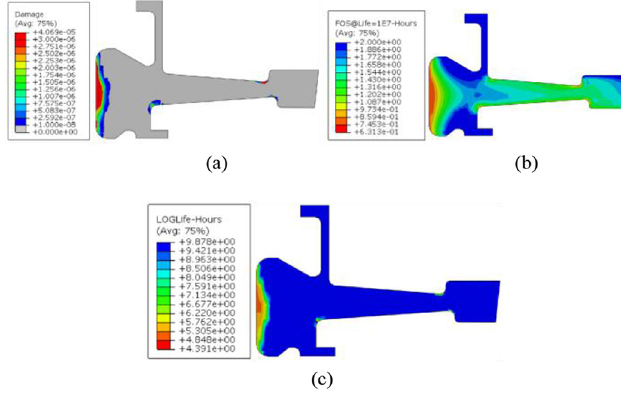
Fig. 9. Results of fatigue damage, FOS factor, and logarithmic fatigue life of FGM disc at maximum speed: (a) fatigue damage distribution of FGM disc, (b) FOS factor distribution nephogram of FGM disc, and (c) logarithmic fatigue life distribution nephogram of FGM disc.